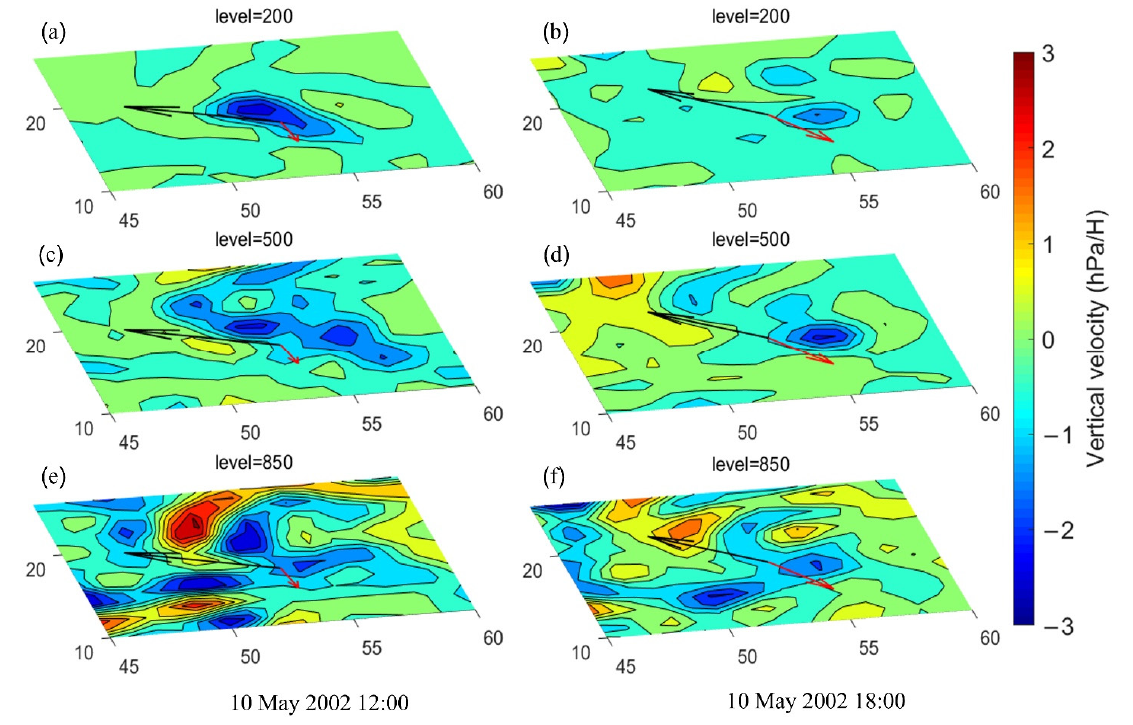
Figure 8. The vertical velocity (hPa/H) distribution of ARB 01 during ( a , c , e ) and after landfall ( b , d , f ) at level = 850 hPa, level = 500 hPa, and level = 200 hPa. The black arrow represents the deep-level environment VWS, and the red arrow represents the low-level environment VWS.